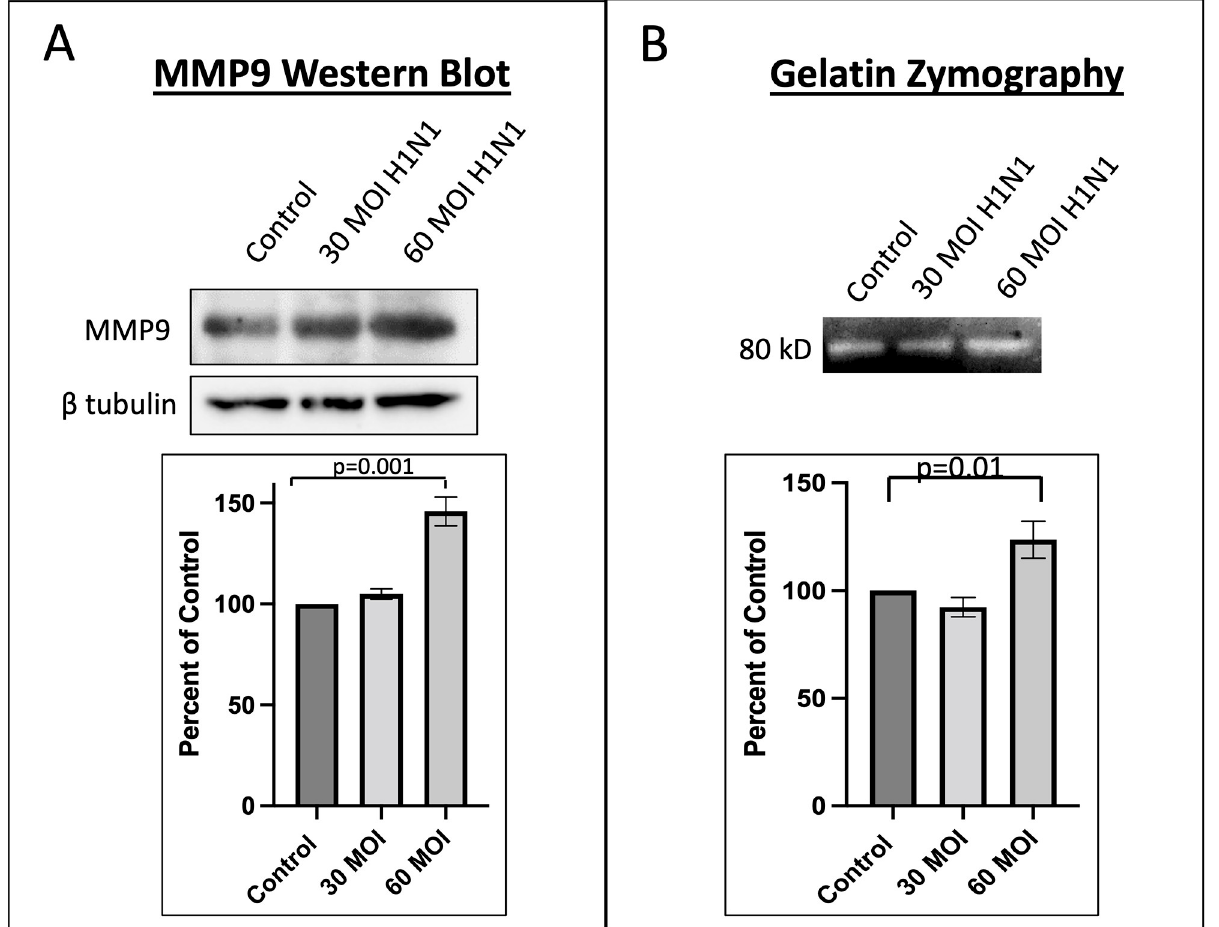
Fig 6. MMP-9 levels as measured by western blot and zymography. A comparison of MMP-9 in human umbilical vein endothelial cells as measured by A) western blot and B) zymography showing that amount of MMP-9 is increased as compared to control when H1N1 infection occurs with multiplicity of infection of 60.